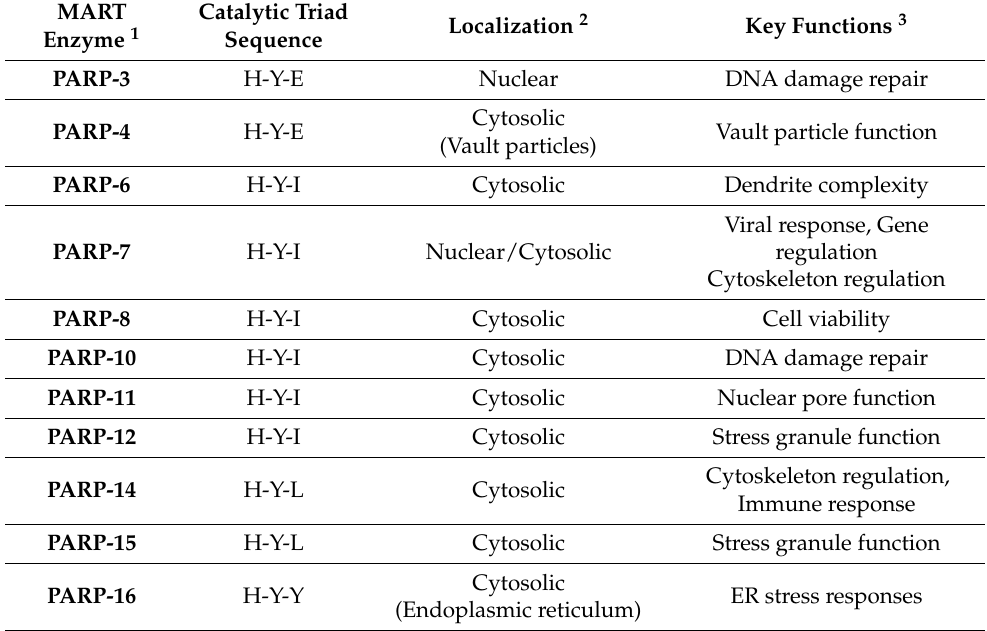
Table 1. Summary of MART